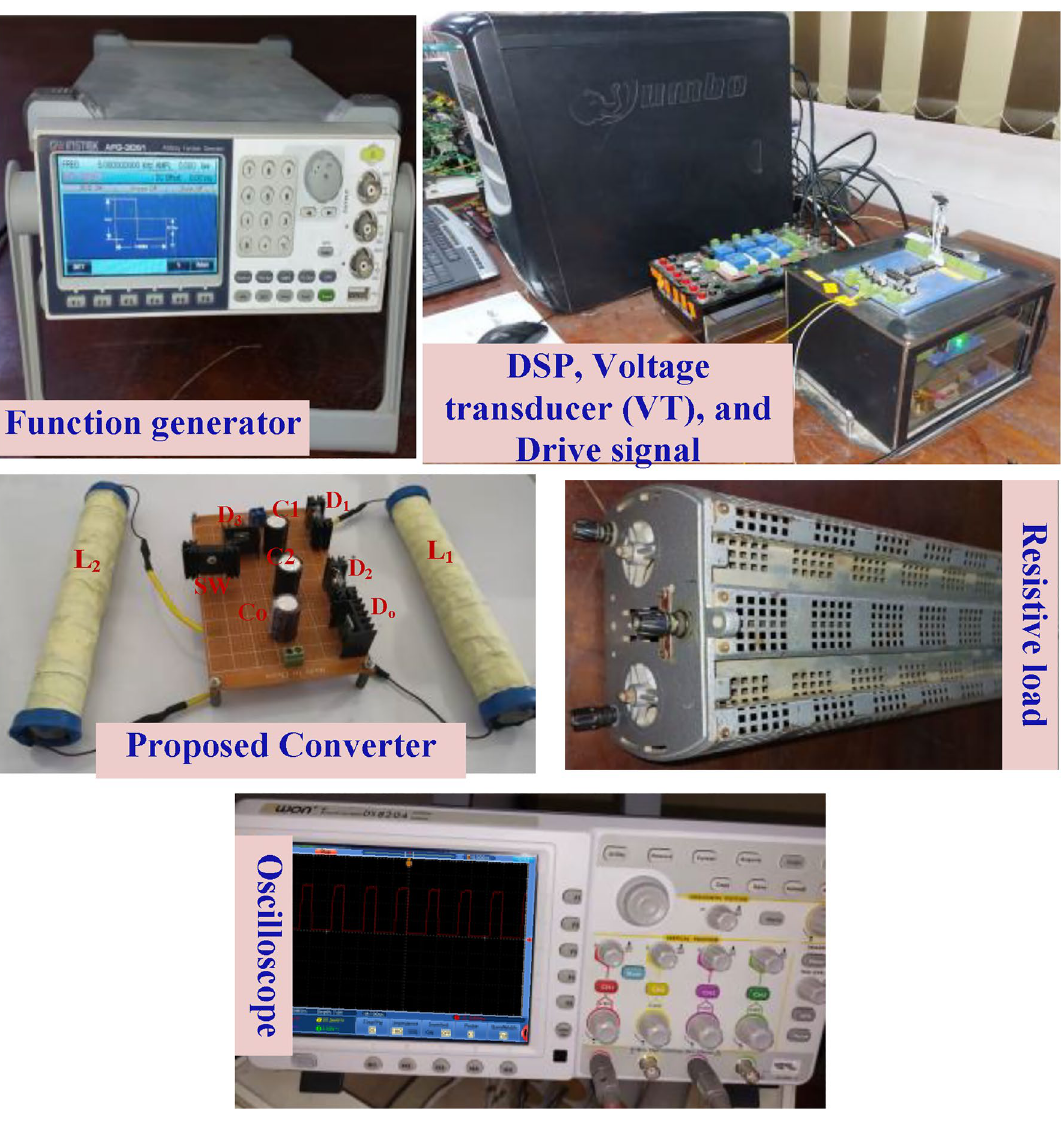
Figure 8. The experimental setup